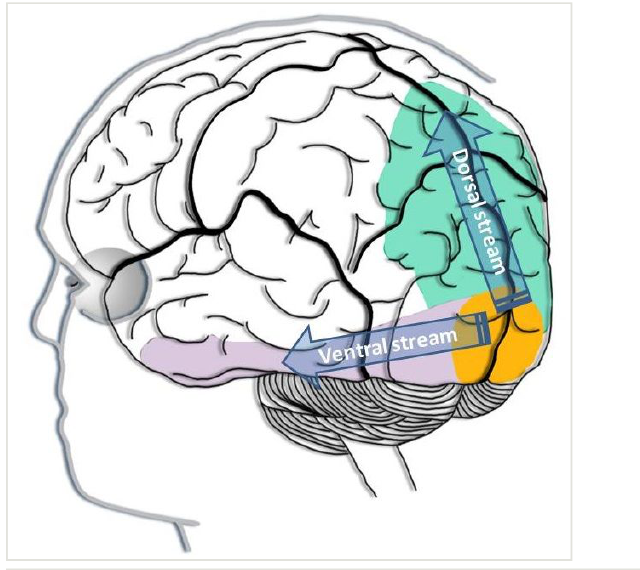
Visual information processing in the cortex. From the primary visual cortex (V1, shown in yellow), the visual information is passed in two streams. The neurons along the ventral stream also known as the ventral visual cortex (shown in purple) are primarily concerned with what the object is. The ventral visual stream runs into the inferior temporal lobe. The neurons along the dorsal stream also known the dorsal visual cortex (shown in green) are primarily concerned with where the object is. The dorsal visual stream runs into the parietal